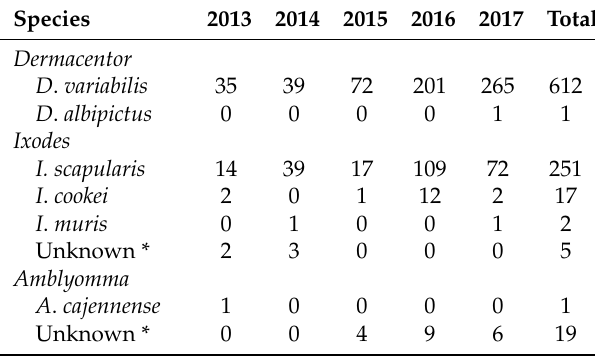
Table 1. Total tick submissions by species submitted through passive tick surveillance in the NWHU catchment area from 2013 to 2017.